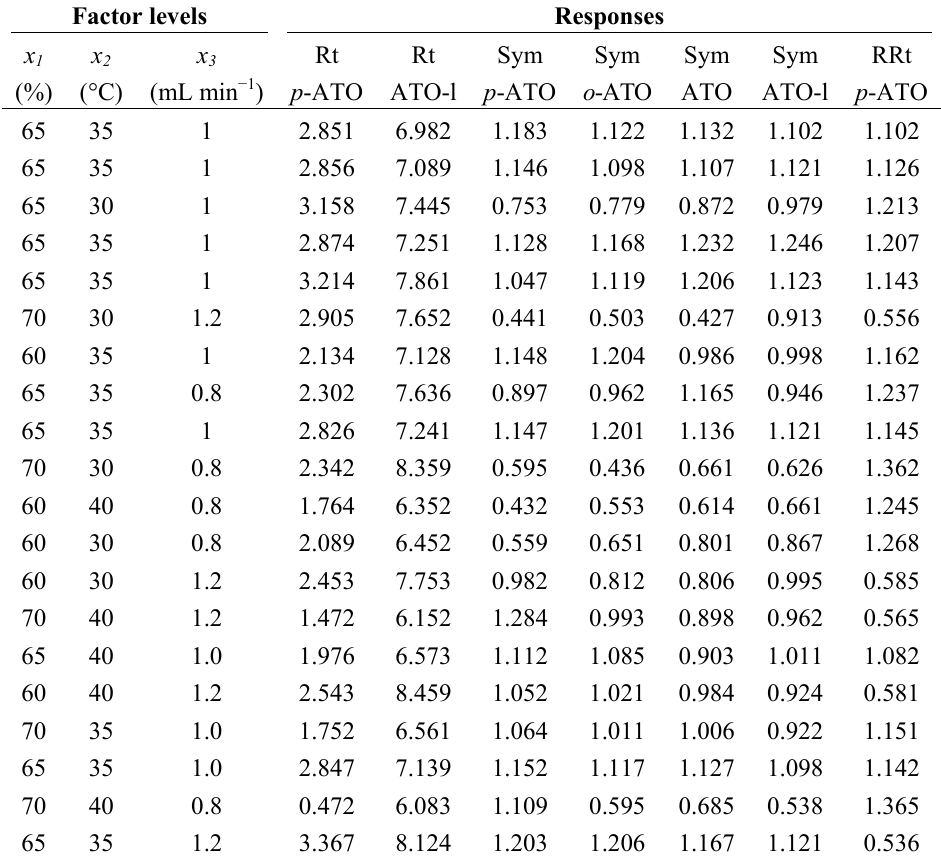
Table 1. Experimental design of the face-centered central composite design and experimentally obtained responses; x -content of acetonitrile in the mobile phase, x 1 temperature of column and x , flow rate, Rt, retention time, Sym, symmetry of compounds, 3 RRt, relative retention